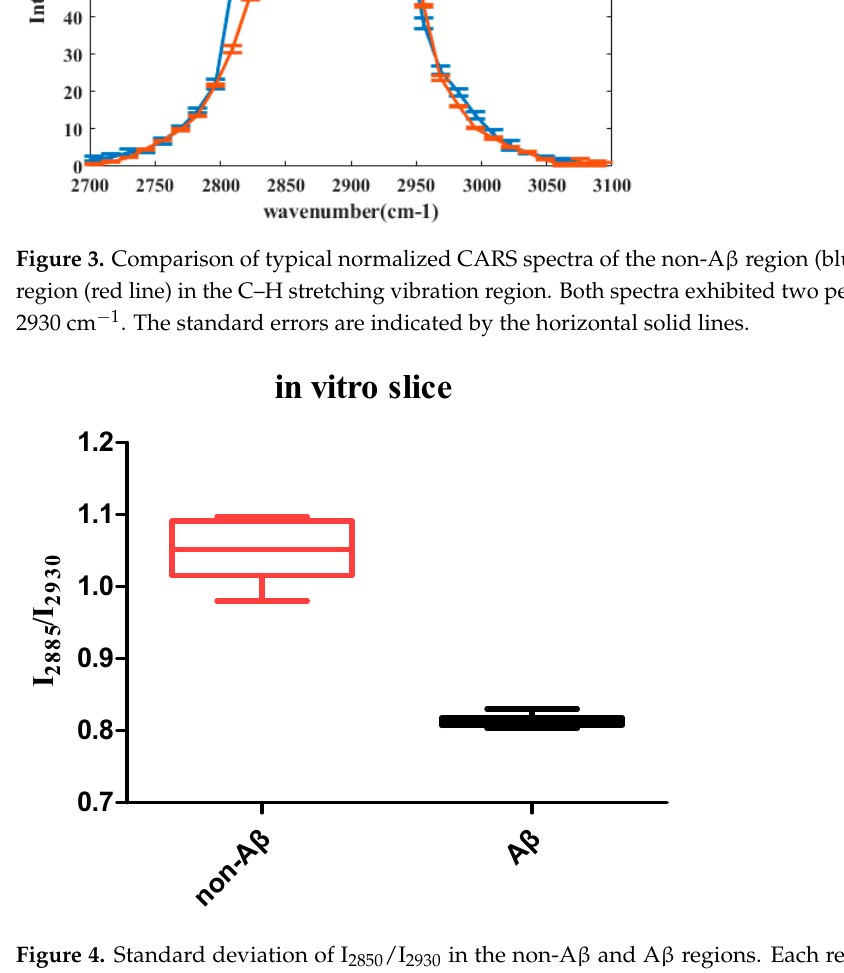
Figure 4. Standard deviation of I 2850 /I 2930 in the non-A β and A β regions. Each region contained 20 sets of data. Each set of data was collected from different slices in vitro.